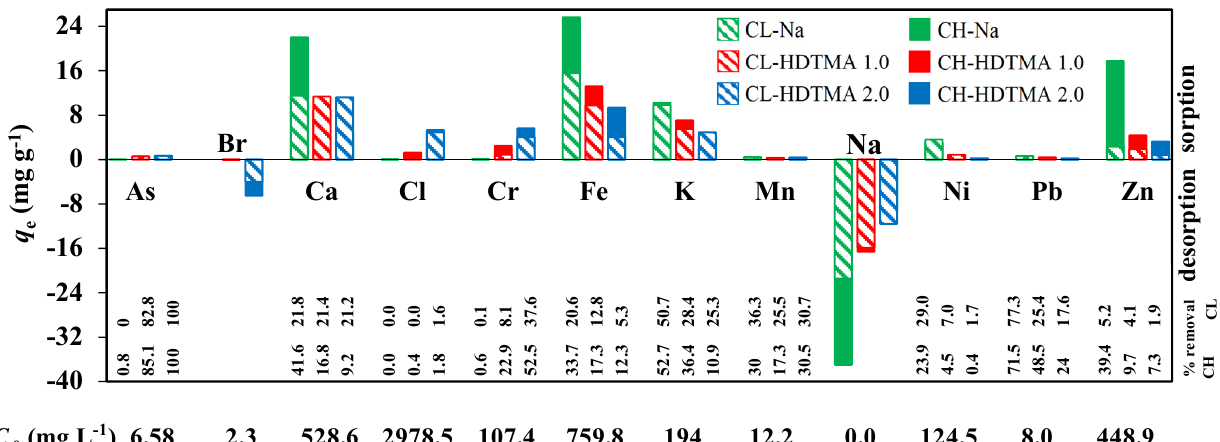
Figure 10. XPS Cr 2p 3/2 spectra of SMZ after Cr(VI) sorption.